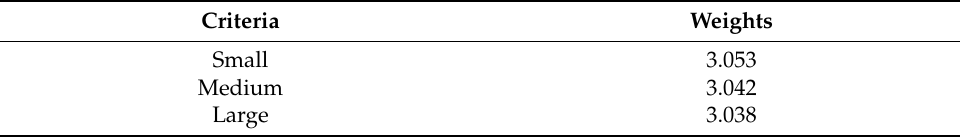
Table 19. The weights